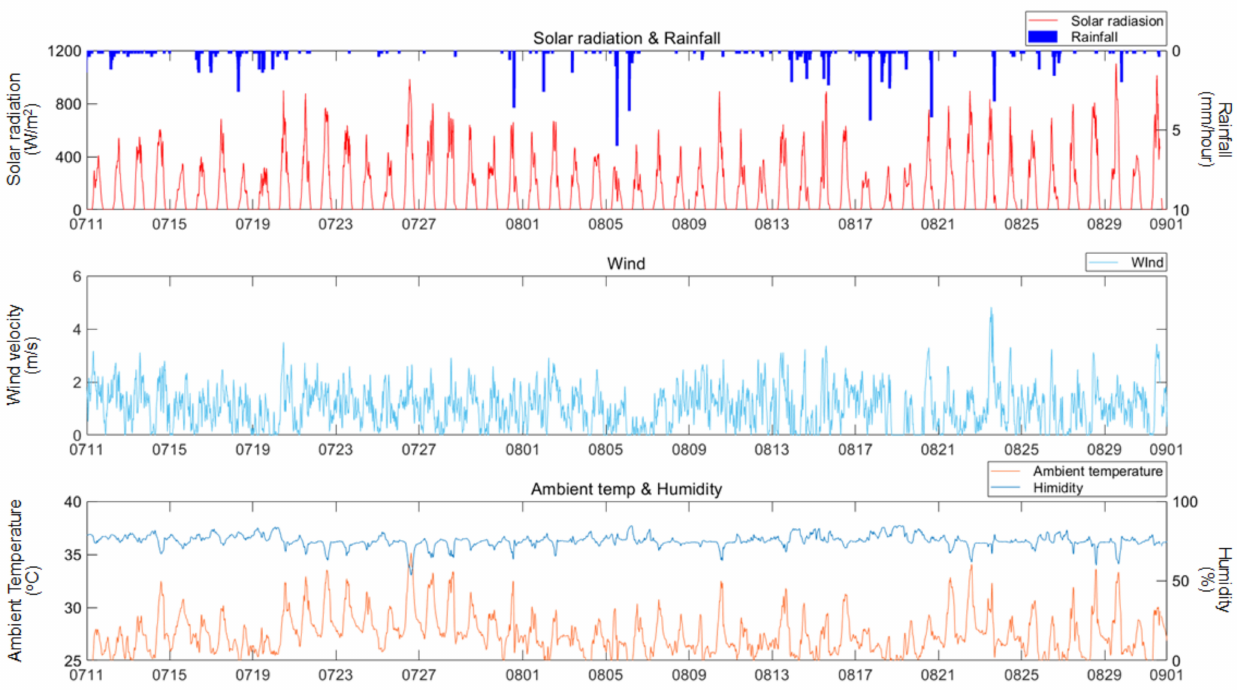
Figure 3. Weather variation time-series. Solar radiation, wind velocity, and air temperature are mean values over 1 h. Rainfall is an accumulated value over 1